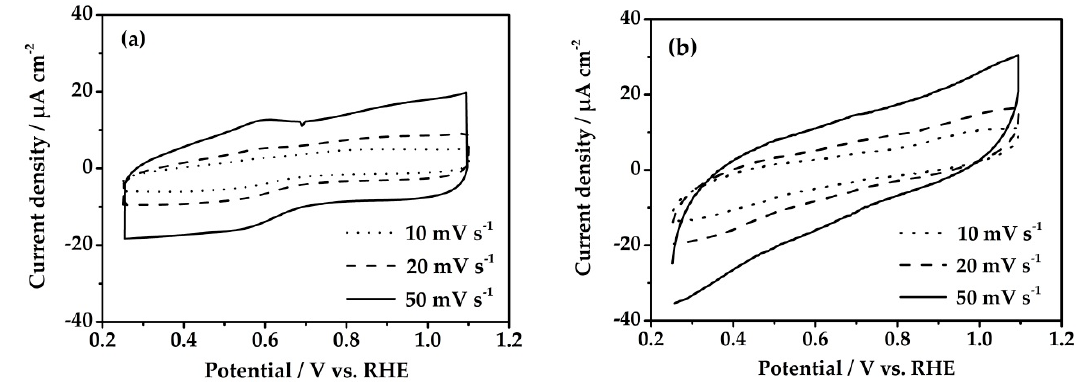
Figure 2. Cyclic voltammetries (CVs) of pre-activated BPPs in 0.5 M H 2 SO 4 at di ff erent scan rates performed in experimental ( a ) set-up A and ( b ) set-up B. RHE, reversible hydrogen electrode.